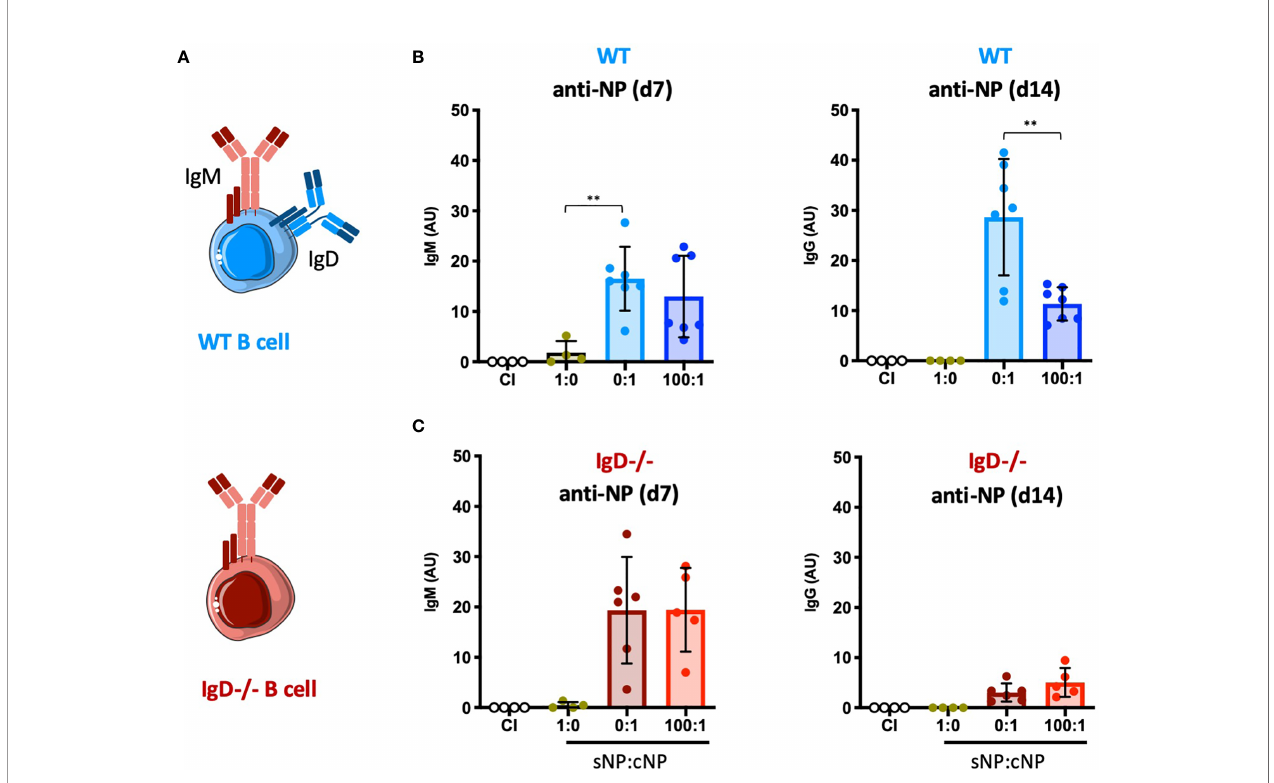
FIGURE 1 | Modulation of immune responses by monovalent antigen requires expression of the IgD-class BCR. (A) Schematic illustrations of a WT and IgD- de fi cient B cell. (B, C) NP-reactive serum immunoglobulins of WT mice (B) and IgD-de fi cient mice (C) injected with PBS (control immunization (CI), n=4/group), 4- hydroxy-3-nitrophenylacetyl only (sNP: 1:0; WT n=4, IgD-de fi cient n=4), complex NP (cNP: 0:1; WT n=7, IgD-de fi cient n=6) and soluble:complex NP (100:1; WT n=7, IgD-de fi cient n=5). Left panel showing anti-NP IgM on day 7, right panel shows anti-NP-IgG on day 14. Mean ± SD, students t-tests with Welch ’ s correction were used to compare two groups within one experiment. **P <